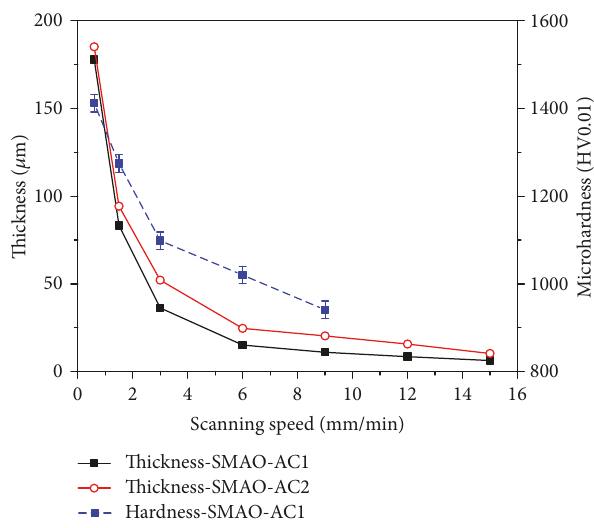
Figure 10: Plot showing coating thickness as a function of cathode travel speed for A356 alloy using a Na 2 SiO 3 and NaOH electrolyte solution (AC1 and 5 mm interelectrode